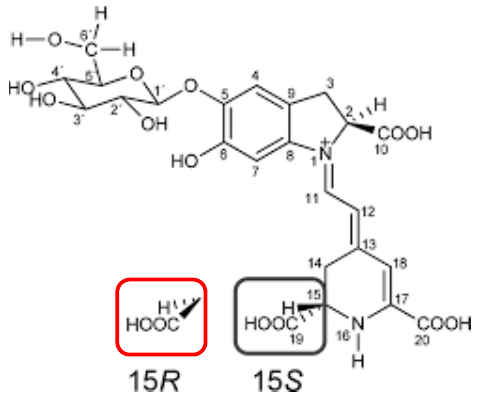
Figure 7. Chemical structures of betanin and isobetanin. The two structures differ in the spatial arrangement of the groups in position 15: betanin 15 S (black), isobetanin 15 R (red).